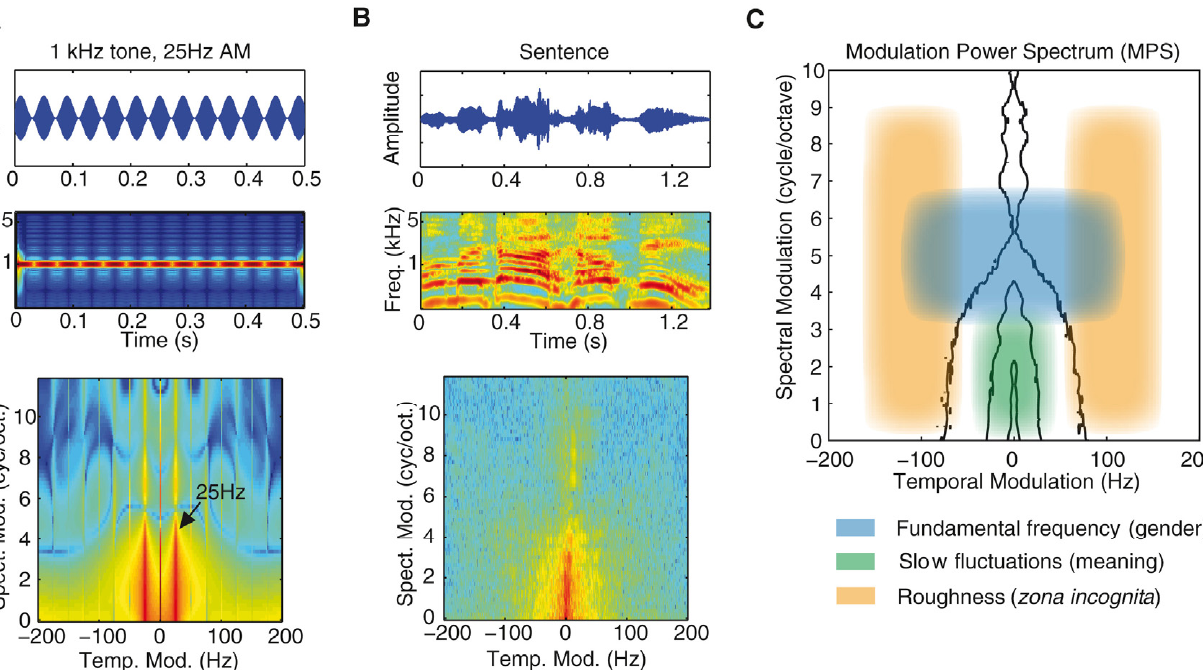
Figure 2. Representations of a 1000 Hz tone amplitude modulated at 25 Hz ( A ) and a spoken sentence ( B ) with waveform (top), spectrogram (middle) and MPS power modulations in the spectral (y axis) and temporal (x axis) domains (bottom). Modulations in human vocal communication ( C ) show how perceptual attributes occupy distinct areas of the MPS and encode distinct categories of information: modulations corresponding to pitch (blue) carry gender/size information; temporal modulations below 20 Hz (green) encode linguistic meaning; and orange rectangles delimit roughness (Figure reproduced without modification from [58] (Copyright © Elsevier 2015, Licence number 5185310806708)).